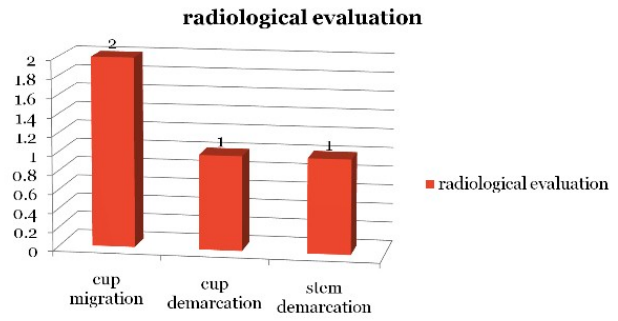
Figure 1. Radiological evaluation of Total Hip Replacements.